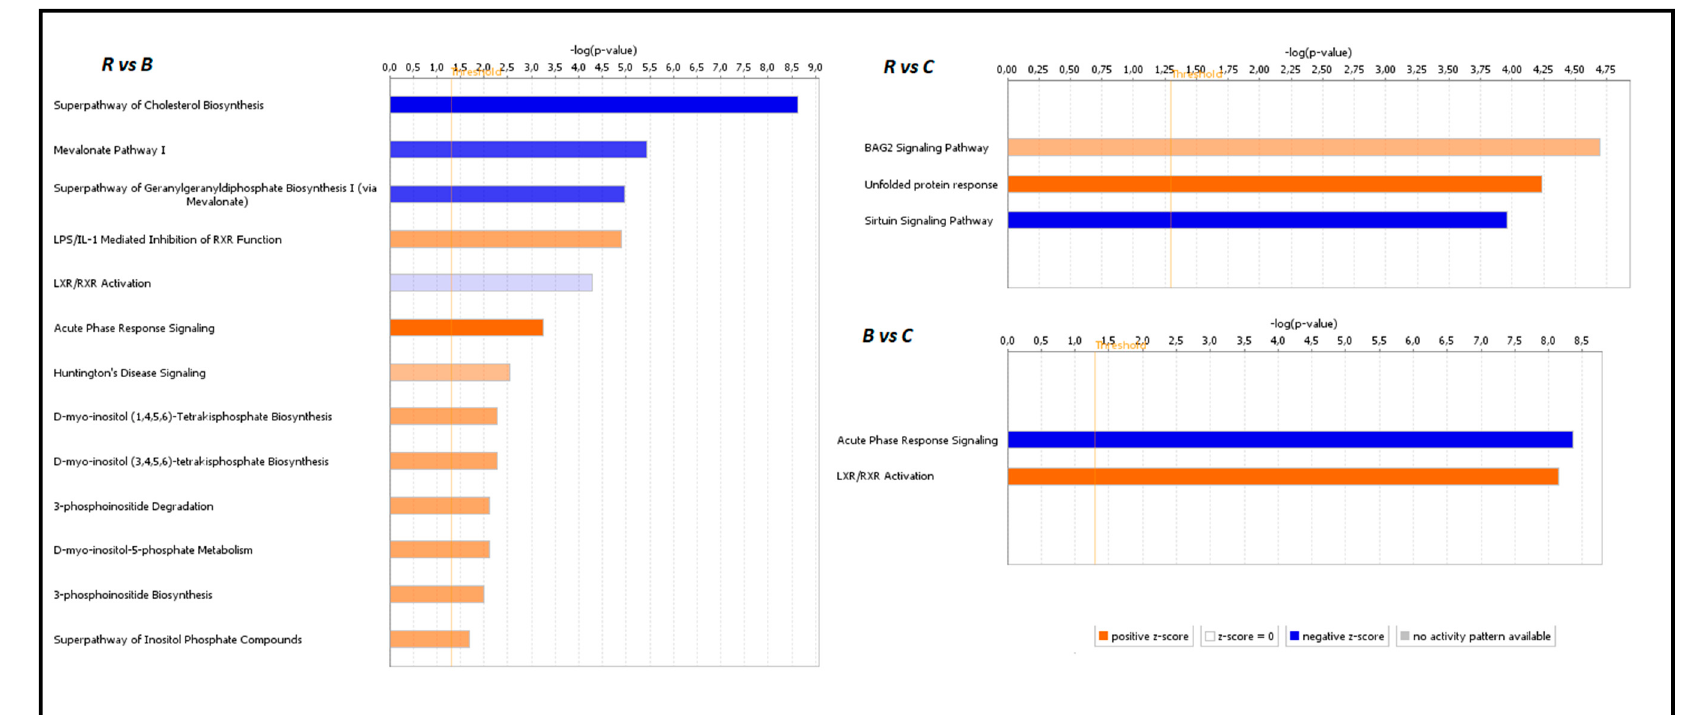
Figure 5. Canonical pathways with Z score ≠ 0 and log ( p -value) > 1.3, identified in each comparison using IPA software.